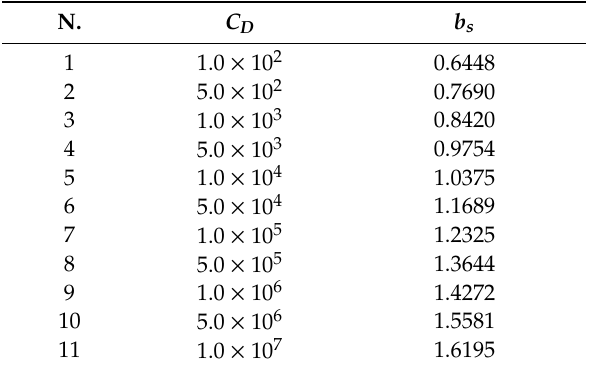
Table 2. b si coe ffi cients for the dimensionless wellbore coe ffi cient, C D .